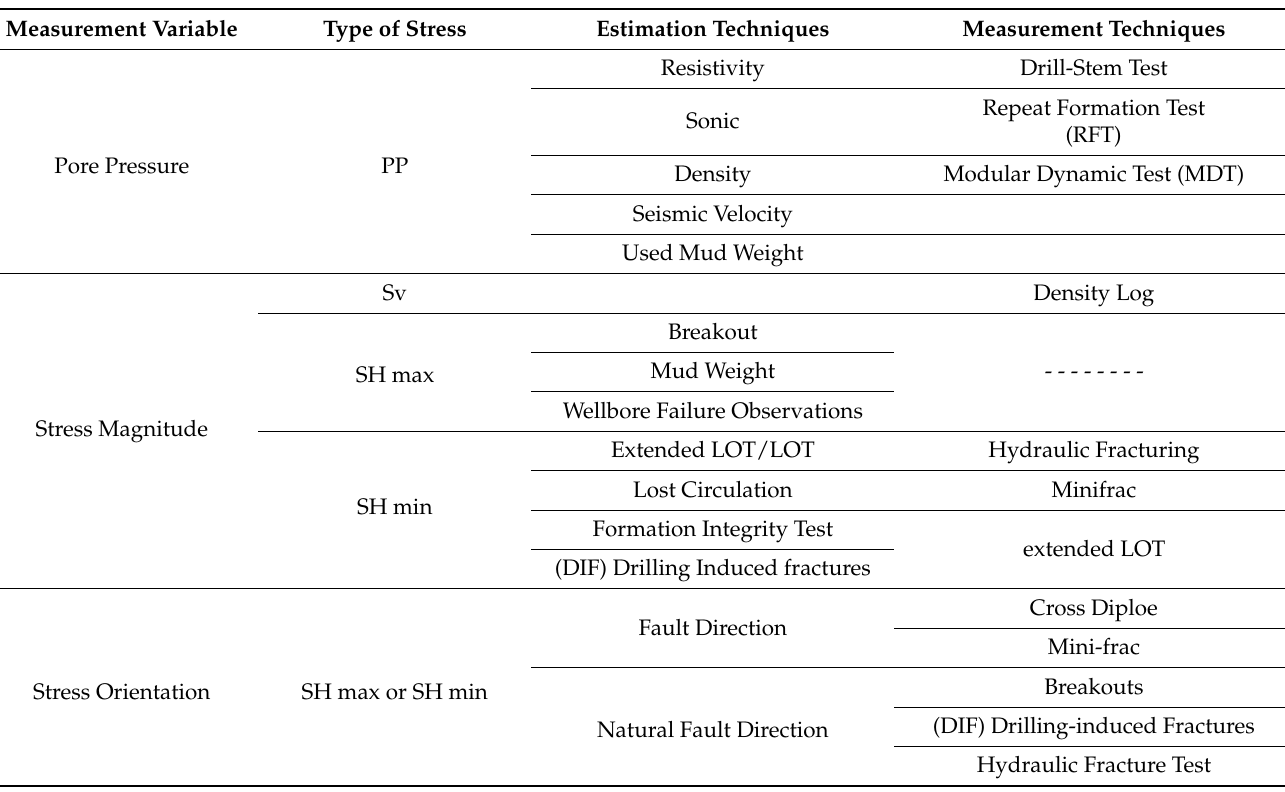
Table 1. In situ stress measurements and estimation techniques in the oil and gas